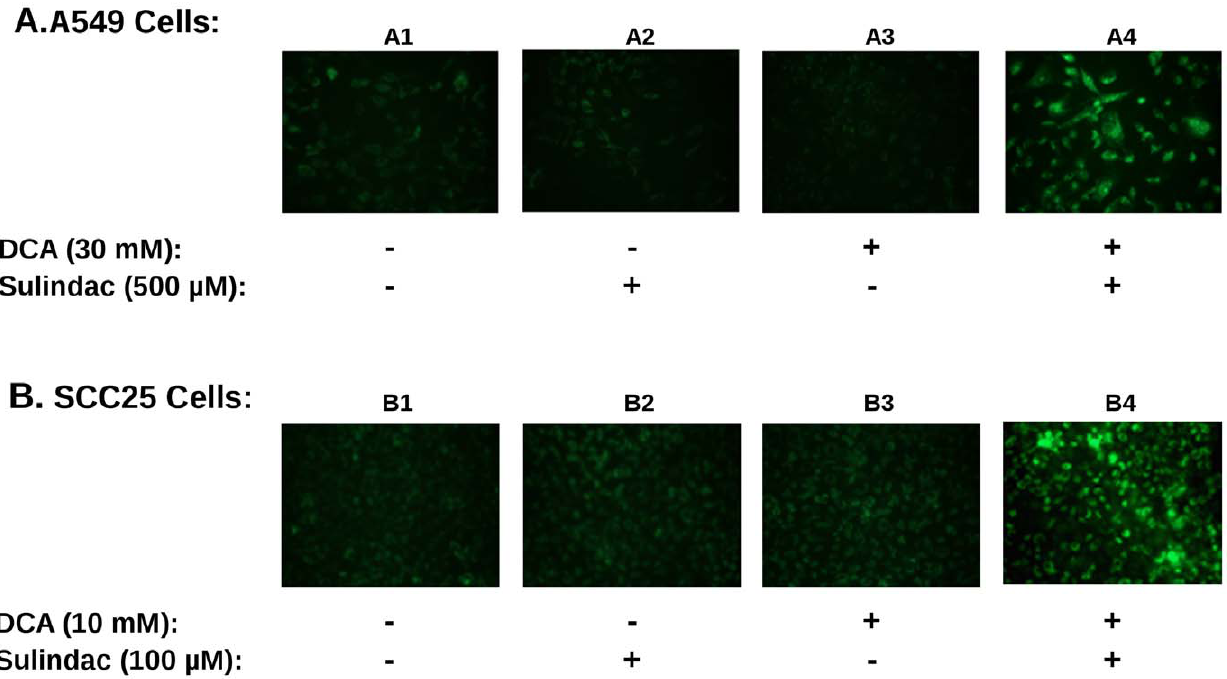
Figure 4. The combination of sulindac and DCA causes disruption of the mitochondrial membrane potential in cancer cells. Top panels (A) illustrate the results for A549 cancer cells while the bottom panels (B) depict the results for SCC25 cancer cells. Mitochondrial membrane potential loss was detected by a change in JC-1 distribution resulting in an increase in green fluorescence (see Methods). The experimental conditions for JC-1 staining and fluorescent microscopy are explained in detail under Methods and the drug treatment regimens are depicted below the panels. Untreated cells (sub-panels A1 and B1), cells treated with sulindac (sub-panels A2 and B2), cells treated with DCA (sub-panels A3 and B3), and cells treated with sulindac and DCA (sub-panels A4 and B4). Several independent fields were photomicrographed and representative fields for each condition are shown.